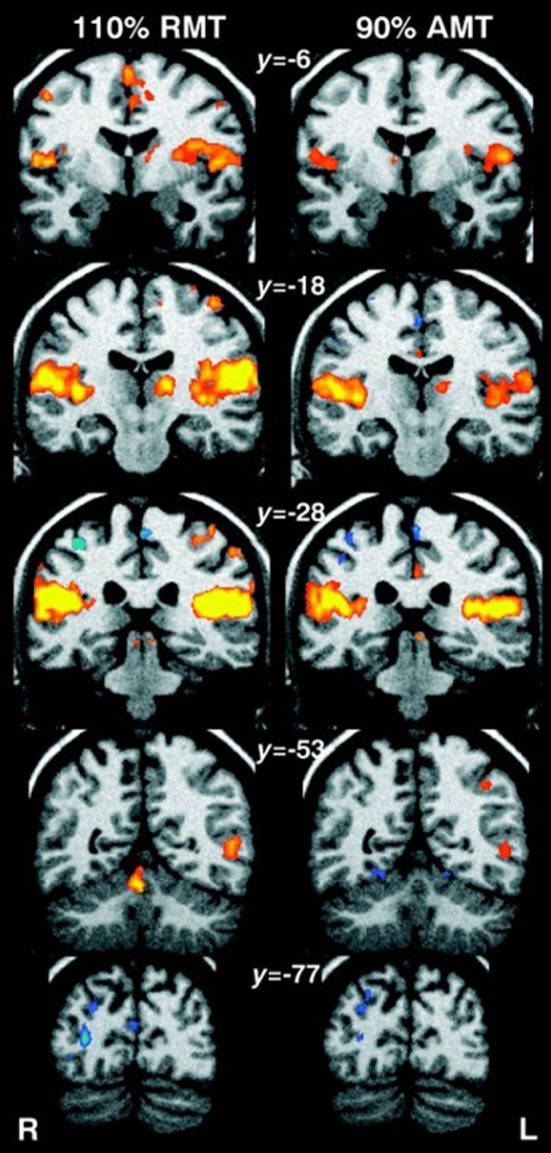
Human fMRI data showing whole-brain effects of (Left) high-intensity rTMS at 110% resting motor threshold (RMT), and (Right) low-intensity rTMS at 90% active motor threshold (AMT). Coronal standard MNI brain sections (Talairach coordinates indicated) with superimposed fMRI results are shown. Areas of significant (n = 11, corrected p < 0.01) activations during rTMS compared to rest have been colored red-yellow, and decrease in fMRI signal in blue. Suprathreshold rTMS induced an increase in activity in the stimulated left sensorimotor cortex, medial supplementary and cingulate motor area, auditory cortex, lateral postcentral region, and left thalamus. Decrease in activity was observed in the right sensorimotor cortex and occipital cortex. Subthreshold rTMS produced similar but smaller activations, with no significant changes in the stimulated brain region. Image from Bestmann et al. (2004). Permission to reuse Figure 7 from the article was granted by John Wiley and Sons and Copyright Clearance Center through their RightsLink® service on 17th of August 2017.